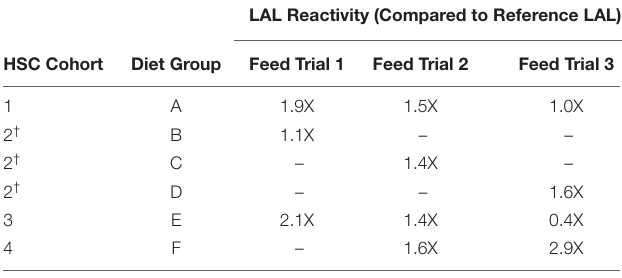
TABLE 4 | Effect of diet on aquaculture LAL vs. Reference LAL